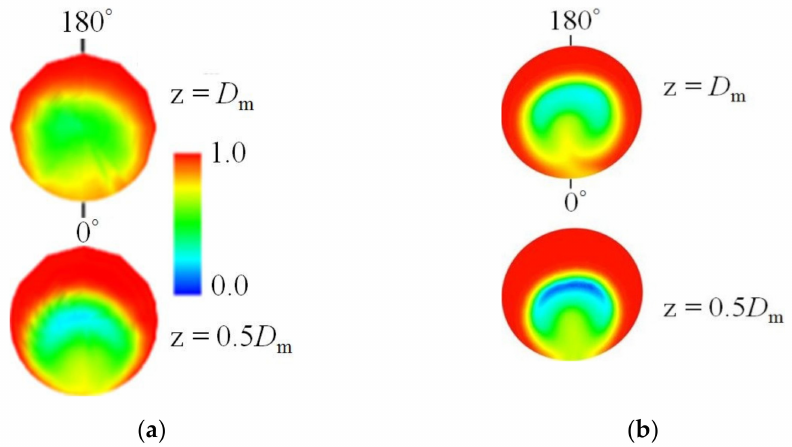
Figure 8. Distribution of the dimensionless temperature T* at Re m /Re b = 1.81: ( a ) LES [9]; ( b ) RANS.